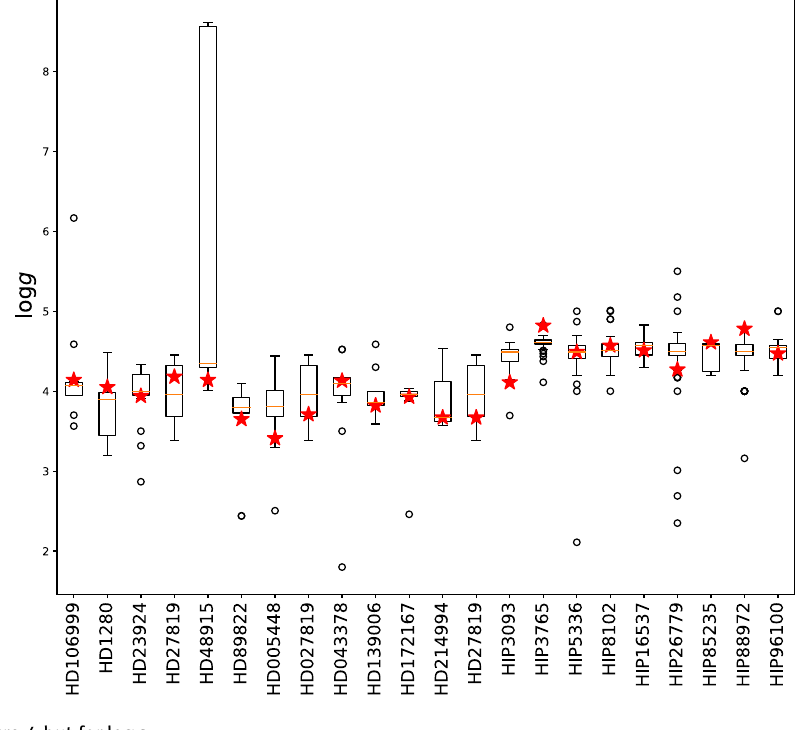
Figure 5: Same as Figure 4 but for g log .